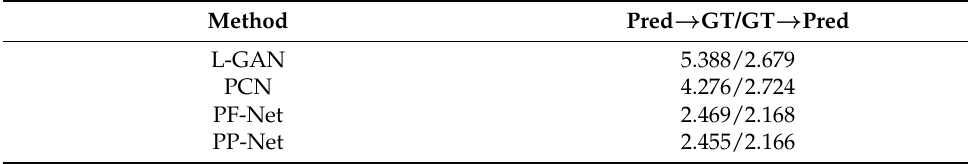
Table 1. Comparison of average errors of different methods.